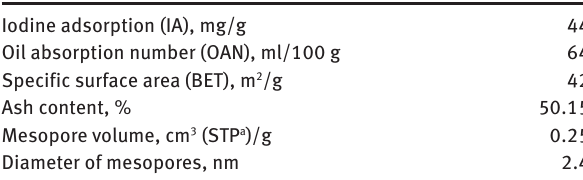
Table 2: Properties of the carbon black-magnetite hybrid filler.